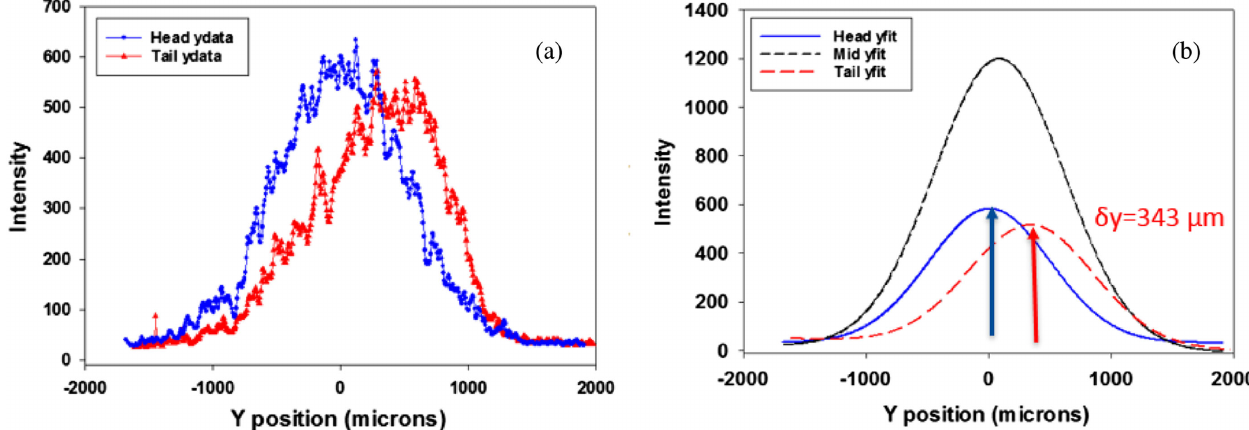
FIG. 5. (a) Transverse y profiles from the head and tail of the Fig. 4(a) Image as found. (b) Gaussian fits to the transverse profiles taken at the head, middle, and tail of the longitudinal distribution. A head-to-tail centroid shift δ y ¼ þ 343 (cid:1) 15 μ m was observed as indicated.